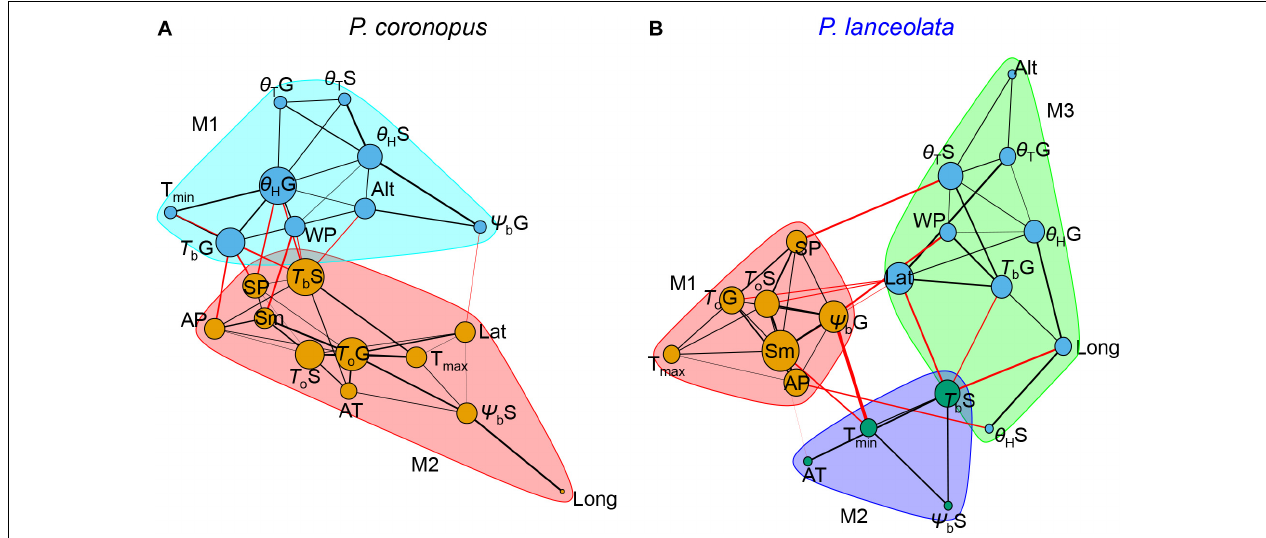
FIGURE 6 | Undirected graph network object of the Spearman’s rank correlation p -values of P. coronopus (A) and P. lanceolata (B) species. The nodes (circles) correspond to the variable traits, and the edges (lines) correspond to the significant rho p -values of two variables in the correlation matrix. The amount of nodes connected depends on the number of significant p -values of one variable with all the other variables. The network graph displays edges that are most likely within (black lines) and among (red lines). Node size corresponds to the degree of connections; edge widths correspond to the logarithm of the edge weight of the p -value between the two nodes; module communities (M-shaded) are based on edge betweenness (Newman–Girvan